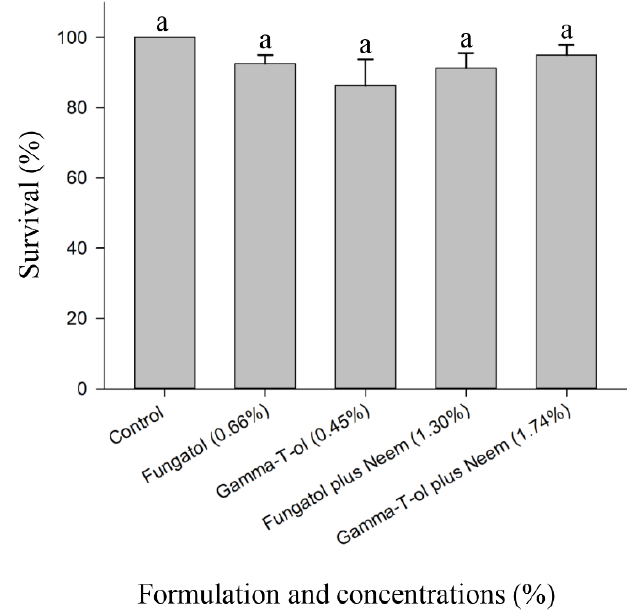
Figure 3. Residual toxicity of Fungatol, Gamma-T-ol, Fungatol plus neem, and Gamma-T-ol plus neem against adults of A. colemani in the laboratory. Each formulation was applied at a concentration resulting in 90% mortality of cotton aphids. The mean differences between the treatments were compared using one-way ANOVA test followed by the Duncan pairwise comparisons test. Different lowercase letters above bars represent significant differences at p < 0.05. Data presented are mean ± SEM.